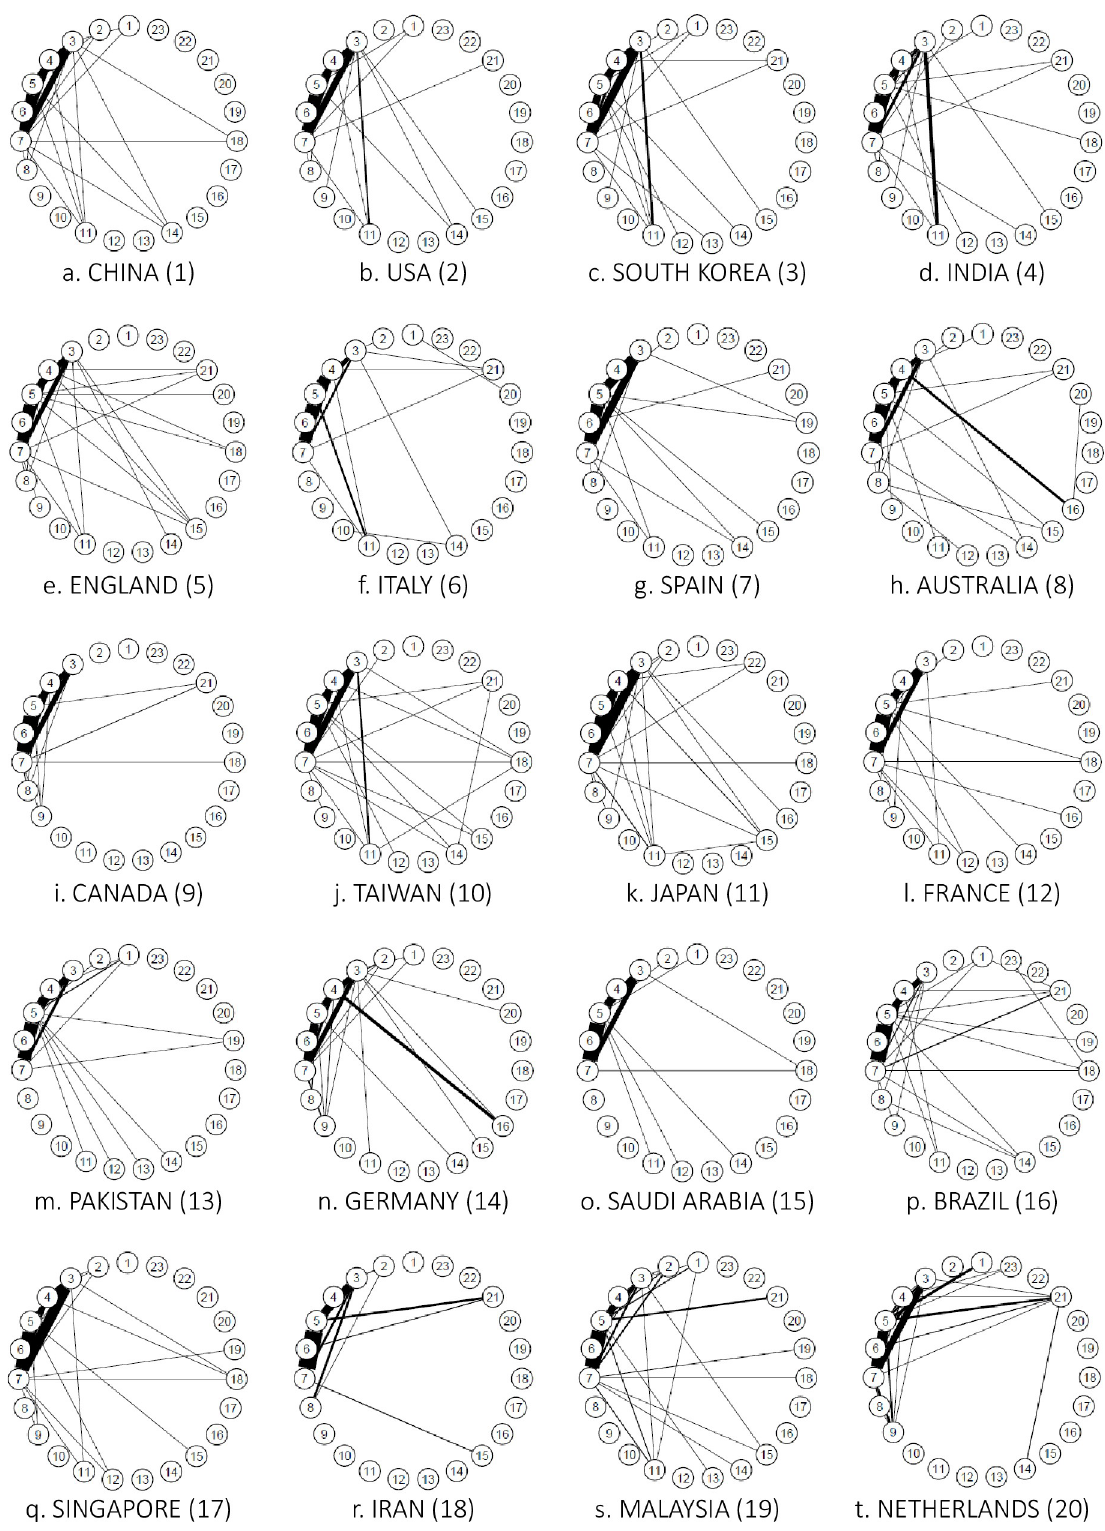
Fig 15. Connections between author research fields in the top 20 countries for internet of things (2018). Note . This indicates connections with a strength of 0.5% or more.